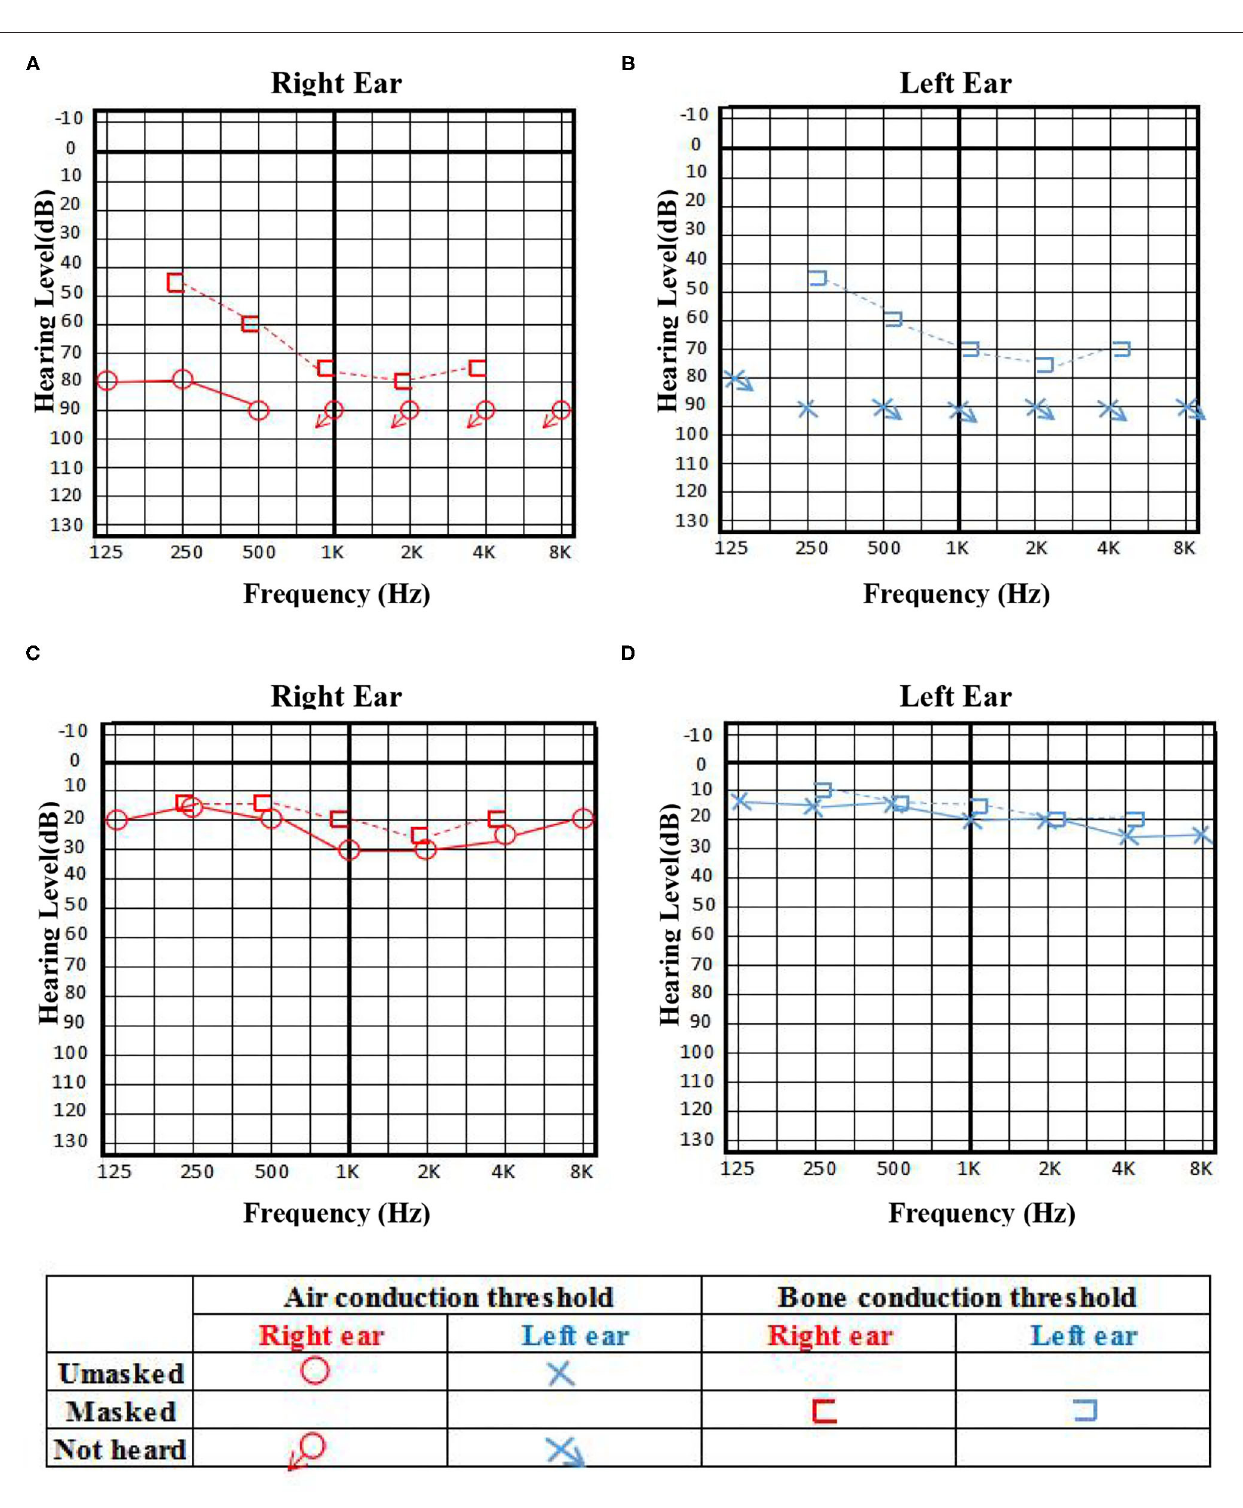
Frontiers in Neurology |